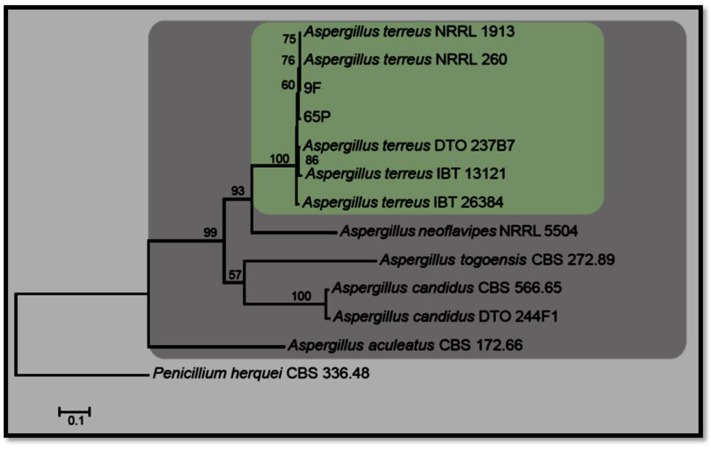
RaXML tree for the analysis Aspergillus spp. based on the combined ITS, TUB, and CMD gene regions. The tree is rooted with Penicillium herquei (CBS 336.48).